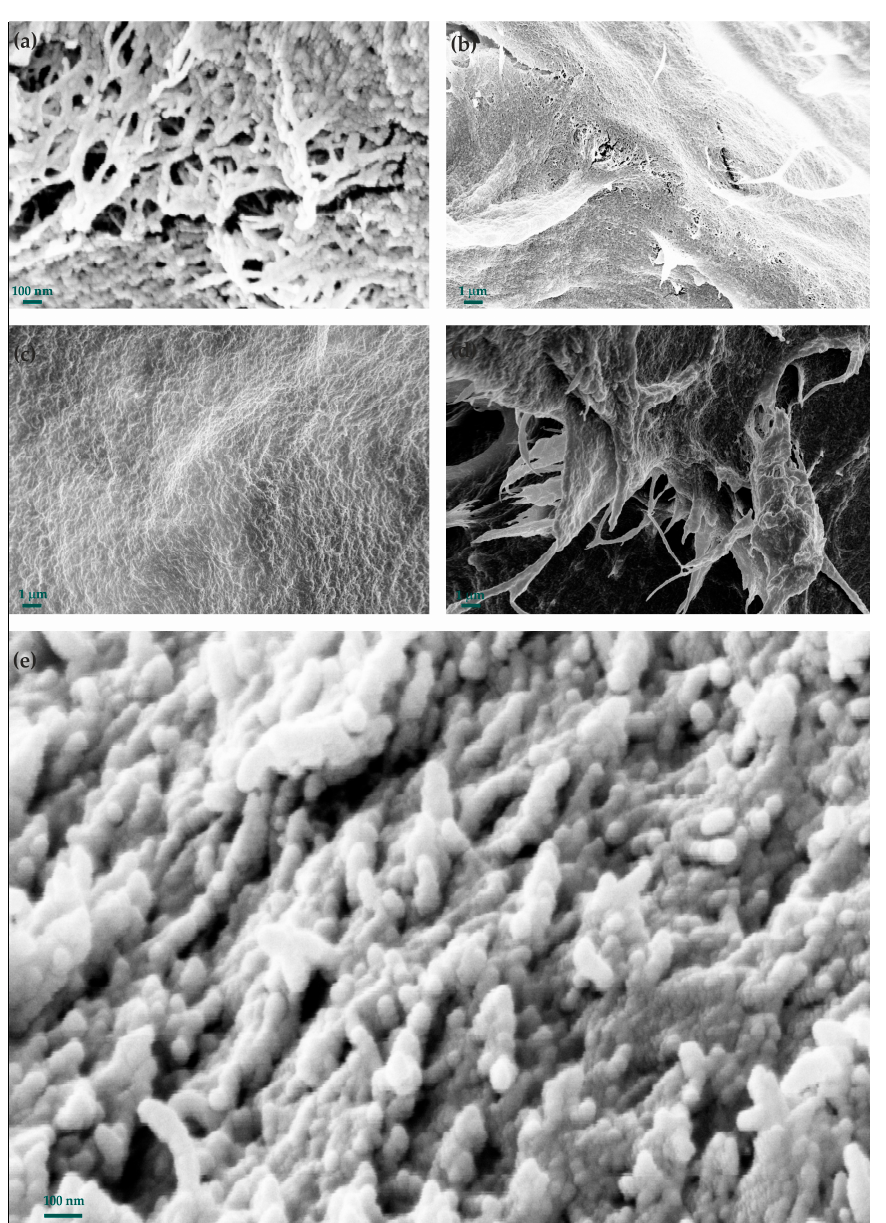
Figure 3. SEM images of cryogel samples from initial and biomodified kraft pulps. ( a , b )—cryogel samples from initial kraft pulp; ( c – e )—cryogel samples from biomodified kraft pulp.